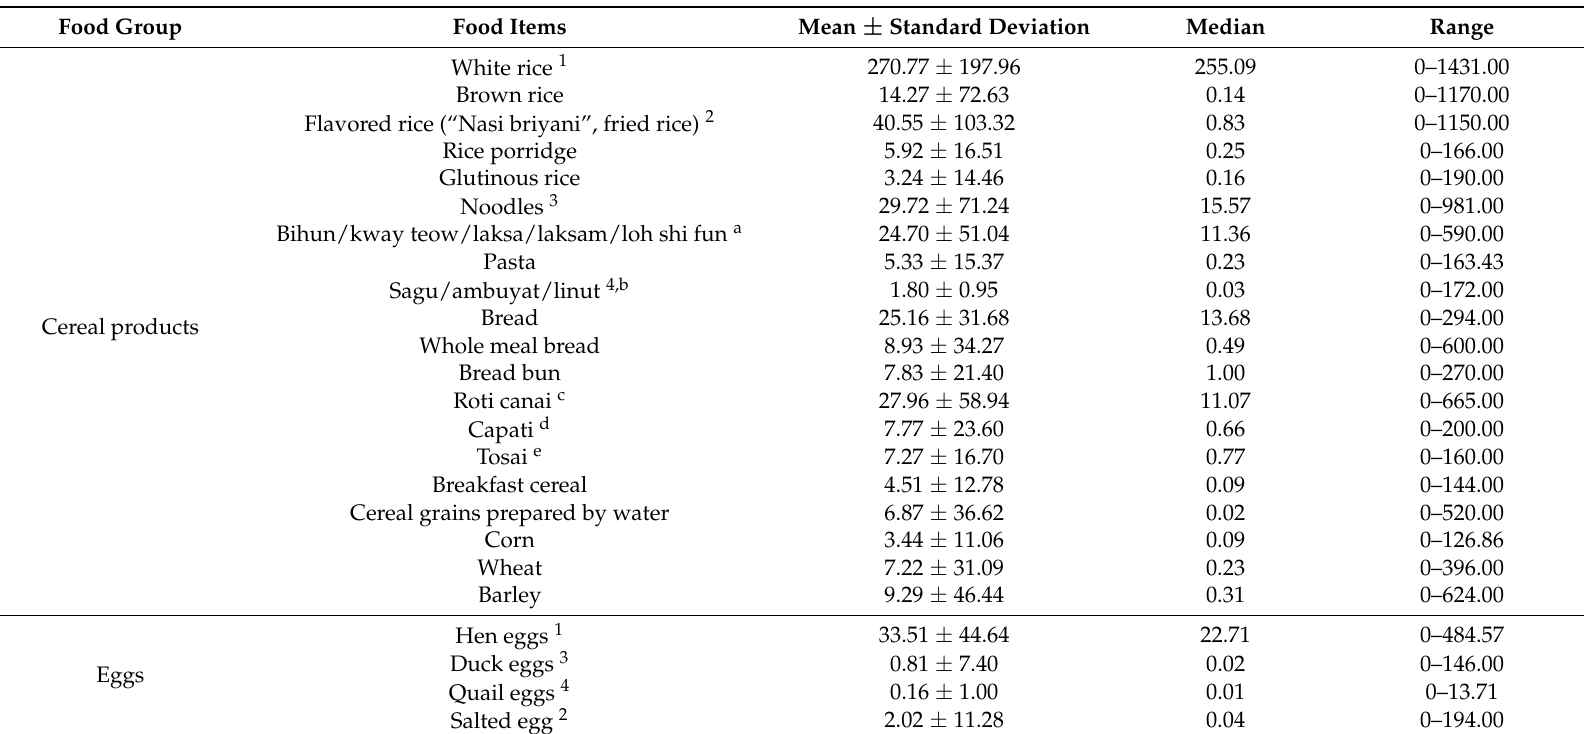
Table A1. Intake of aflatoxin-potentially-contaminated food ( n =